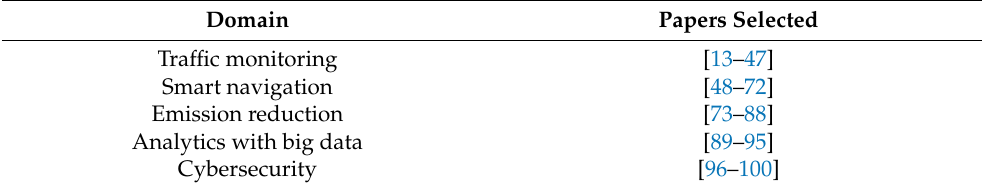
Table 4. Clustering of the selected studies by